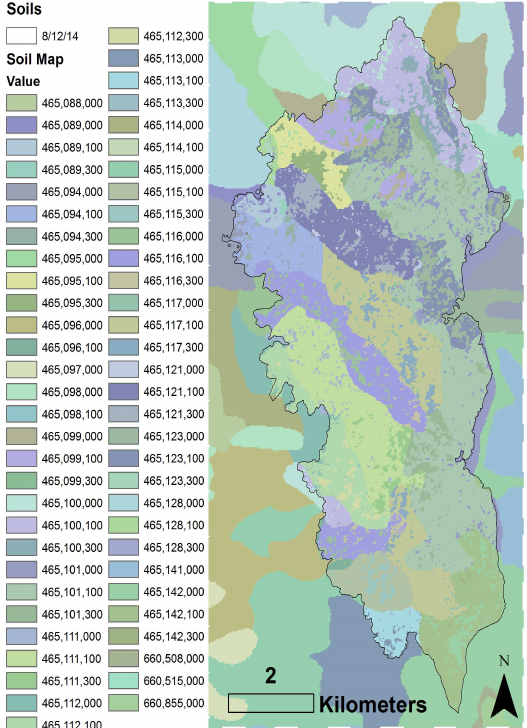
Figure 4. A soils map generated by the database depicting soil files modified by the burned French Fire land cover layer. To facilitate modeling the corresponding WEPP soil parameter and linkage files are also provided by the online database.